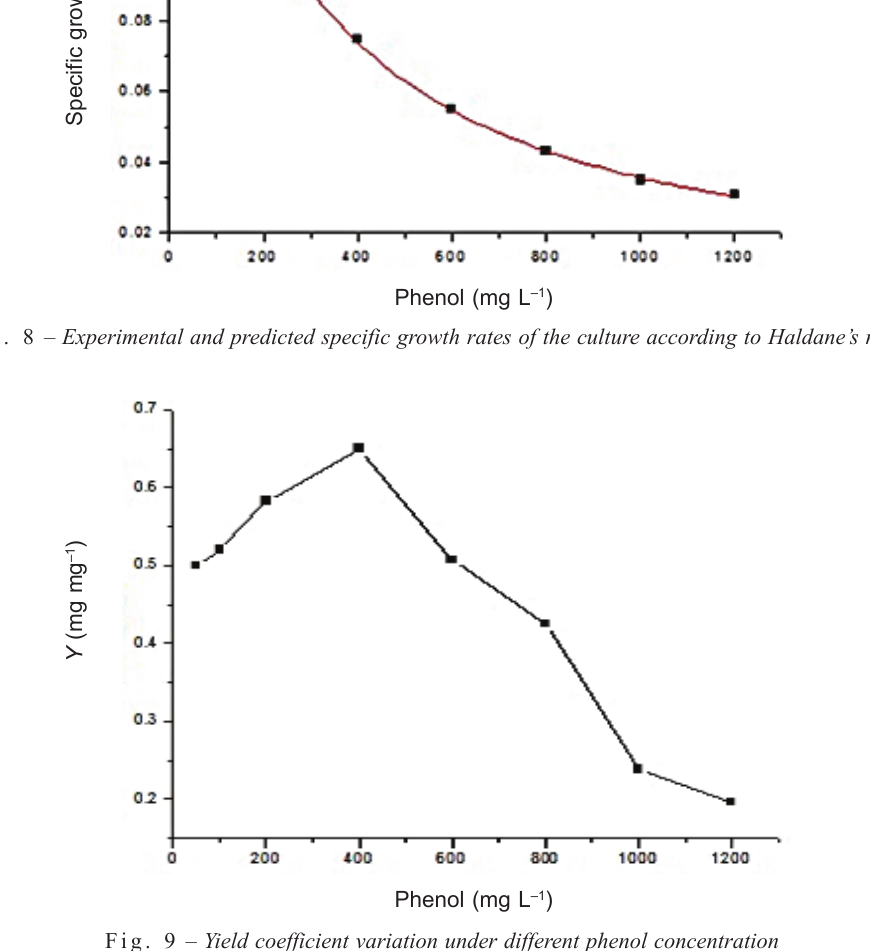
Fig. 9 – Yield coefficient variation under different phenol